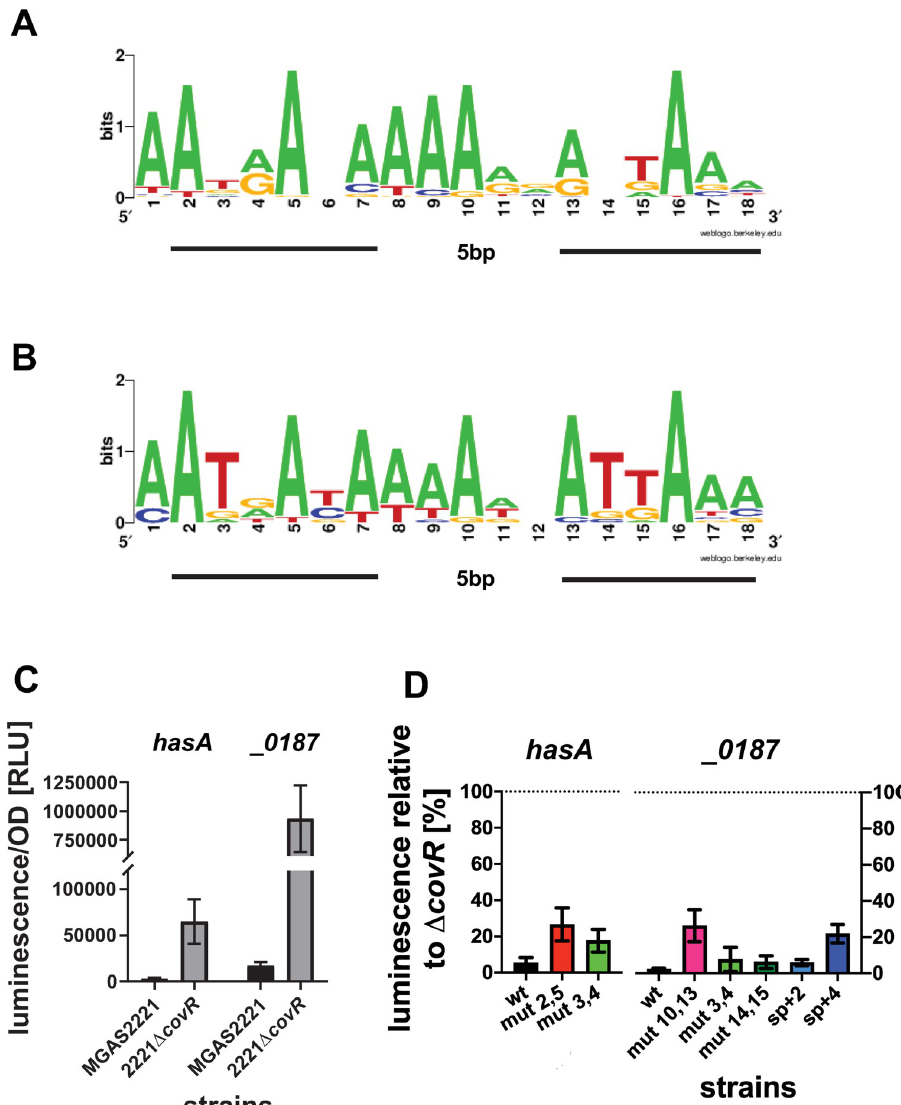
Fig 5. Delineation and validation of a CovR binding motif. Sequence logos generated by WebLogo [71] using CovR binding sites found by MEME generated from (A) 45 genes directly regulated by CovR and (B) the 16 genes with peaks featuring the highest reads per length (RPKL > 500). The two tandem repeat motifs are underlined, respectively. (C) luxAB reportergene assay determining CovR repression of hasA and MGAS2221_0187 in wild type strain MGAS2221 and relief of repression in strain 2221- Δ covR as measured in RLUs. (D) Effect of mutations within the putative CovR binding site in the promoters of hasA and MGAS2221_0187 on gene transcription. Relative luminescence (RU per OD) is depicted in relation to luminescence in the respective 2221 Δ covR background, which represents the unrepressed state (set to 100%). Cells of three biological replicates were grown in THY at two independent experiments with data shown being mean ± standard deviation. mut x,y: mutation of two bases to cytosine at position x and y within the putative DNA binding motif found in the promoters of hasA or MGAS2221_0187 , respectively. sp+2 and sp+4: insertion of two or four guanosines in the 5bp spacer region of the putative motif. reporter gene was provided on a plasmid in the MGAS2221 and 2221 Δ covR background, respectively, and the luminescence signal per OD was detected as a measure of promoter activ- ity (Fig 5C). As expected, for both hasA and MGAS2221_0187 wild type promoters, lumines- cence was virtually absent in the MGAS2221 background indicating strong repression of gene